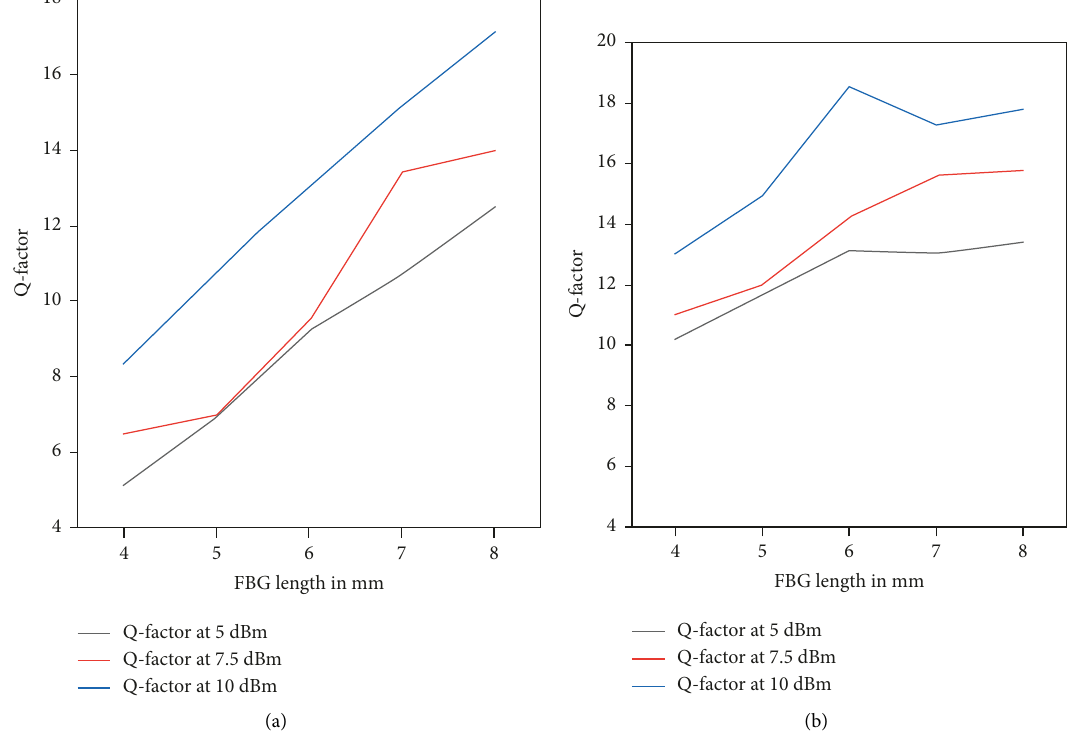
Figure 4: A comparison of Q-factor results for 5dBm, 7.5dBm, and 10dBm for 3 FBG+DCF: (a) Gaussian profile and (b) tanh